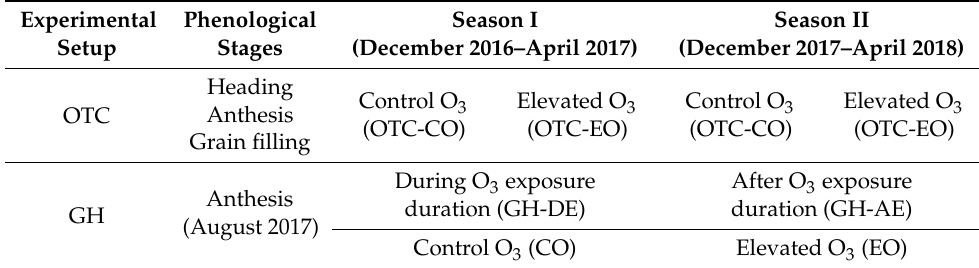
Table 1. Experimental setup scheme for OTC and GH